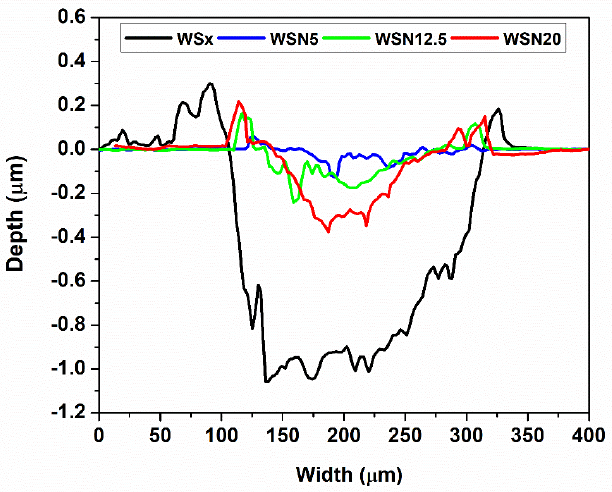
Figure 2. 2D wear tack profiles of the wear tracks vacuum sliding tests.